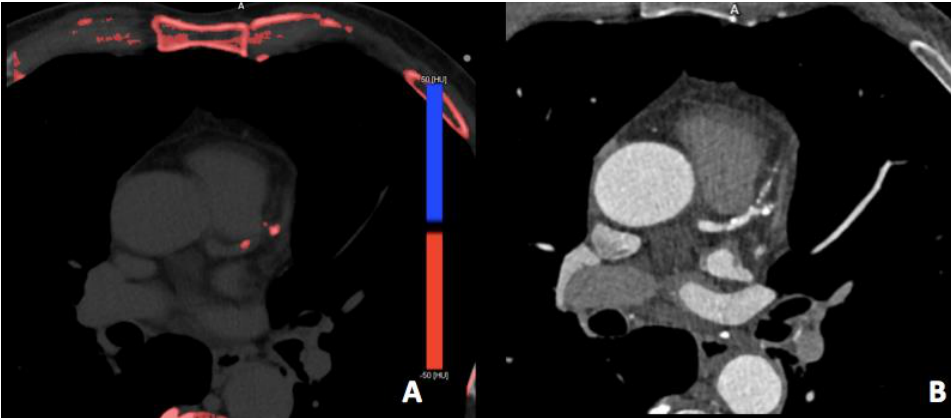
Figure 4. Calcium scoring from coronary dual-source DECT angiography. Virtual non-contrast ( A ) and the corresponding DECT ( B ) images in a 56-year-old man with a virtual Agatston score of 73 on LAD.